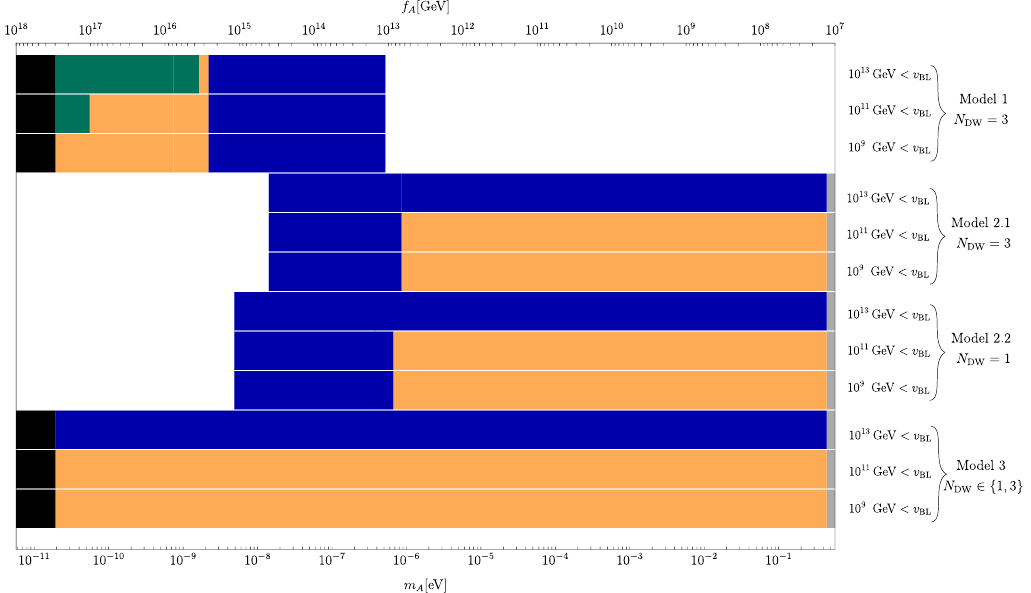
Figure 4 . Possible ranges of the axion mass and decay constant consistent with gauge coupling uni(cid:12)cation in our models, for the case where scalar threshold corrections have been taken into account. Regions in black are excluded by constraints from black hole superradiance, regions in blue by proton stability constraints. Regions in green are disfavoured depending on the allowed range of the B-L breaking scale. Regions in gray are excluded by non-observation of excessive cooling of helium burning stars by axion